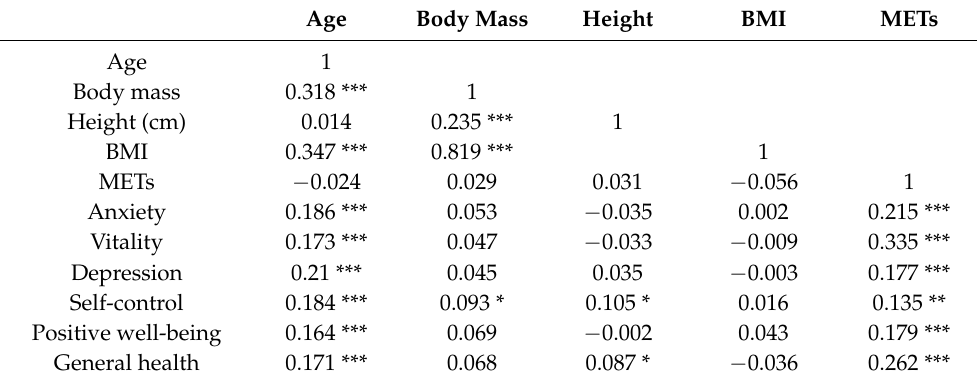
Table 5. Correlations between study